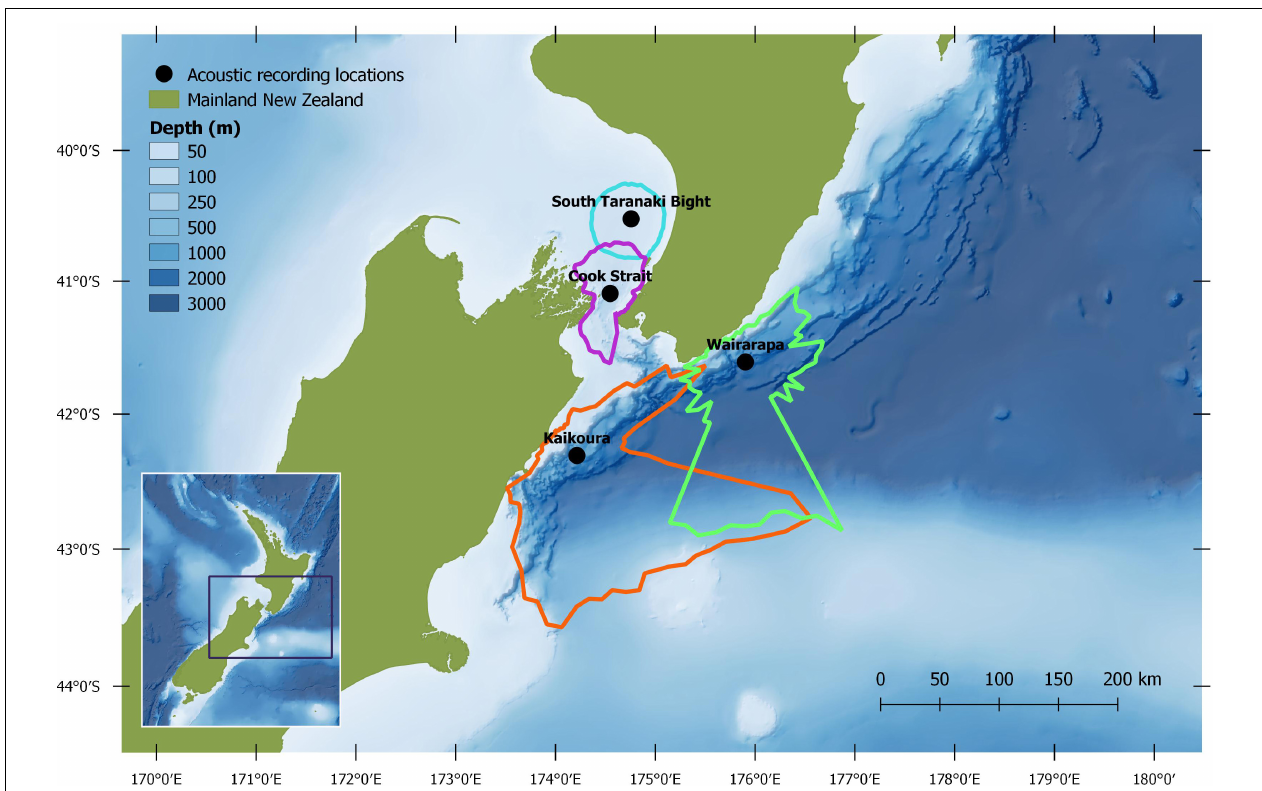
FIGURE 2 | Study region, with median modelled pygmy blue whale detection areas for March 2017: turquoise = South Taranaki Bight, purple = Cook Strait, green = Wairarapa, orange = Kaik¯oura. See Methodology for modelling configuration and